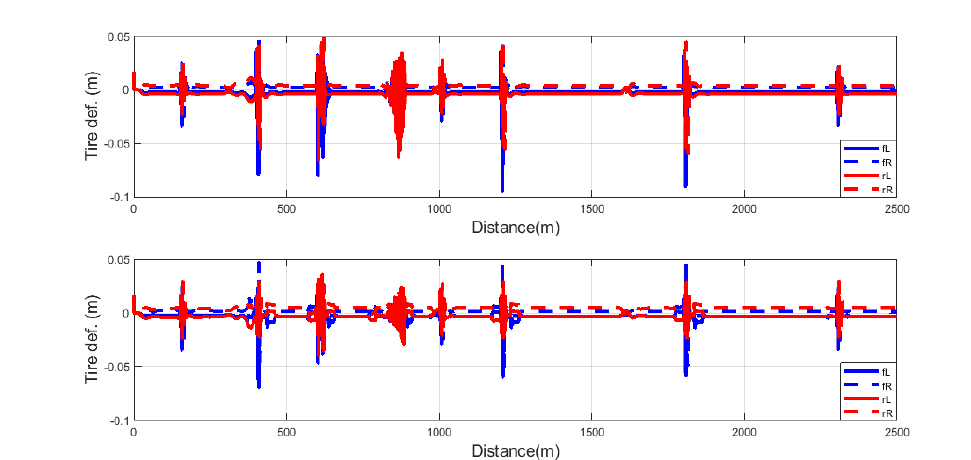
Figure 13. Tire deformation: non-adaptive ( top ) and adaptive ( bottom